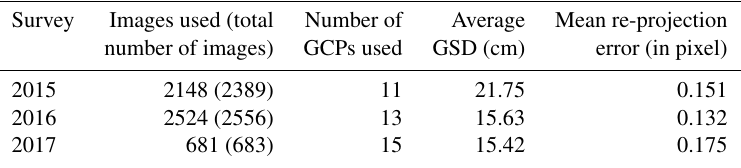
Table 2. Image processing summary.